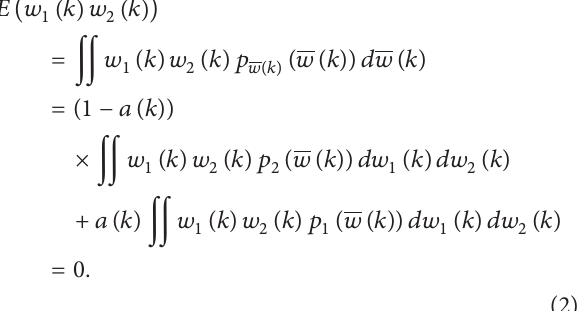
After substitution of mixture model in the definition of 𝐸(𝑤 1 (𝑘)𝑤 2 (𝑘)) , we can see that this pdf represents